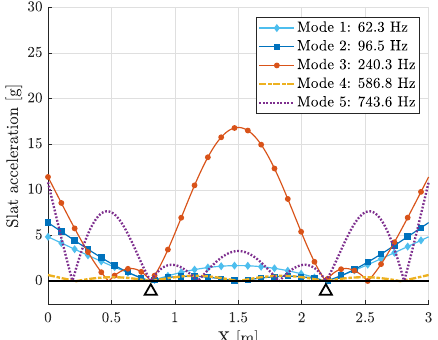
Figure 16. RMS values of the acceleration at any point of the slat due to the single mode of the slat with a trapezoidal load